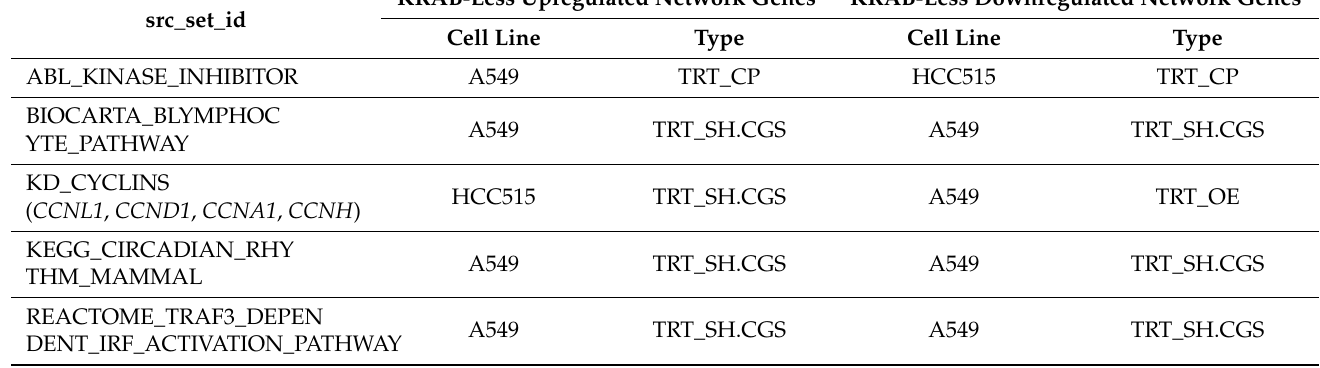
Table 5. The common significant ( p < 0.05, connectivity score > 0.9) functional pathways from CMap using ZNF71 KRAB-less upregulated network genes (Figure 5E) and ZNF71 KRAB-less downregulated network genes (Figure 5F) as